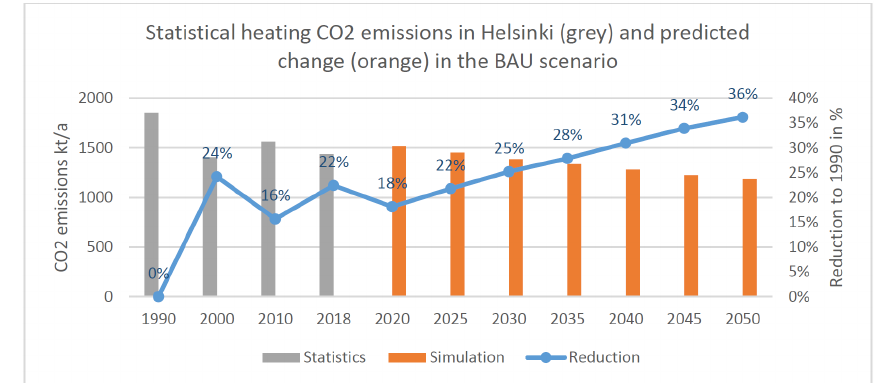
Figure 10. Statistical heating demand (gray) and predicted heating demand (orange) in Helsinki, assuming a 1% refurbishment rate in the BAU scenario.